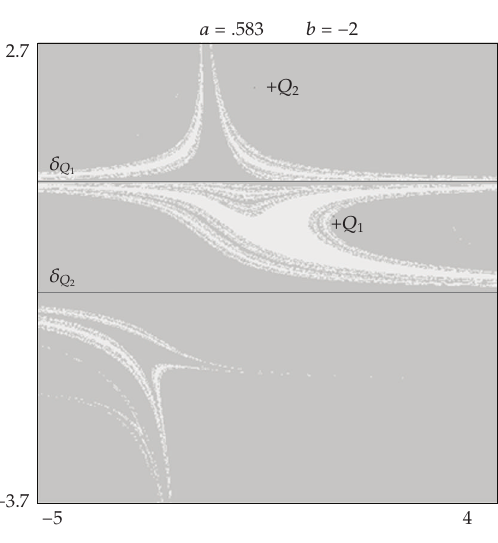
Figure 6: a (cid:2) 0 . 583 basin of attraction non